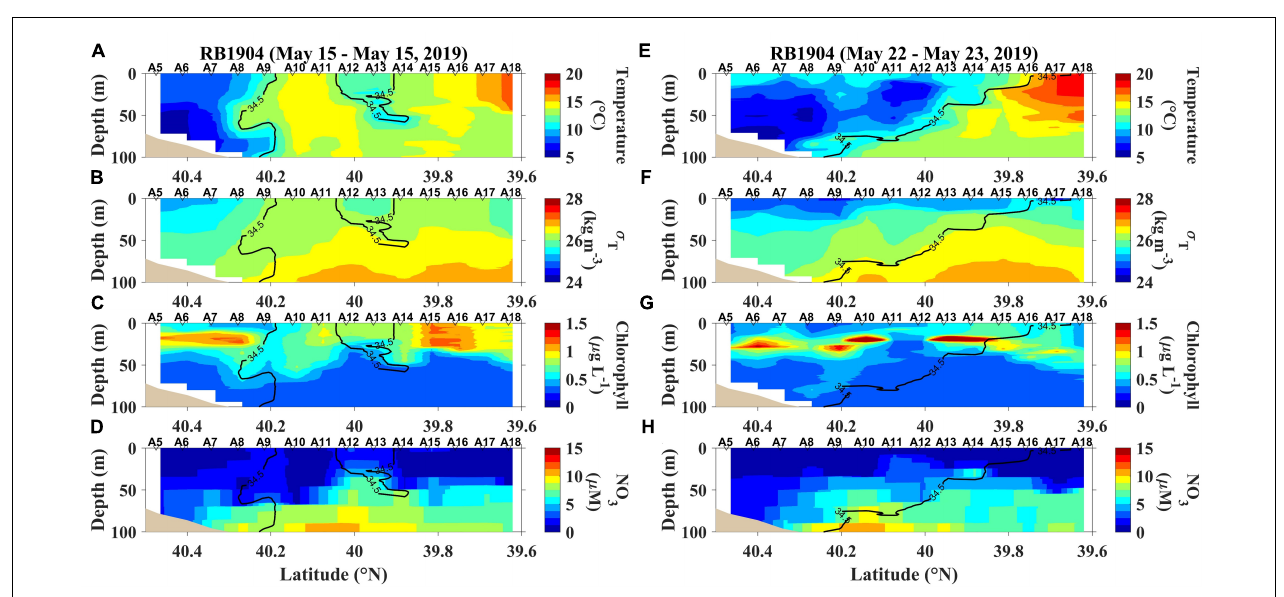
FIGURE 2 | The first and last section occupied during AR29. (A) temperature, (B) density (expressed as σ T ), (C) chlorophyll and (D) nitrate concentrations (NO 3 ) sampled from April 17–18, 2018, and (E) temperature, (F) density (expressed as σ T ), (G) chlorophyll and (H) nitrate concentrations (NO 3 ) sampled from April 27–28, 2018.